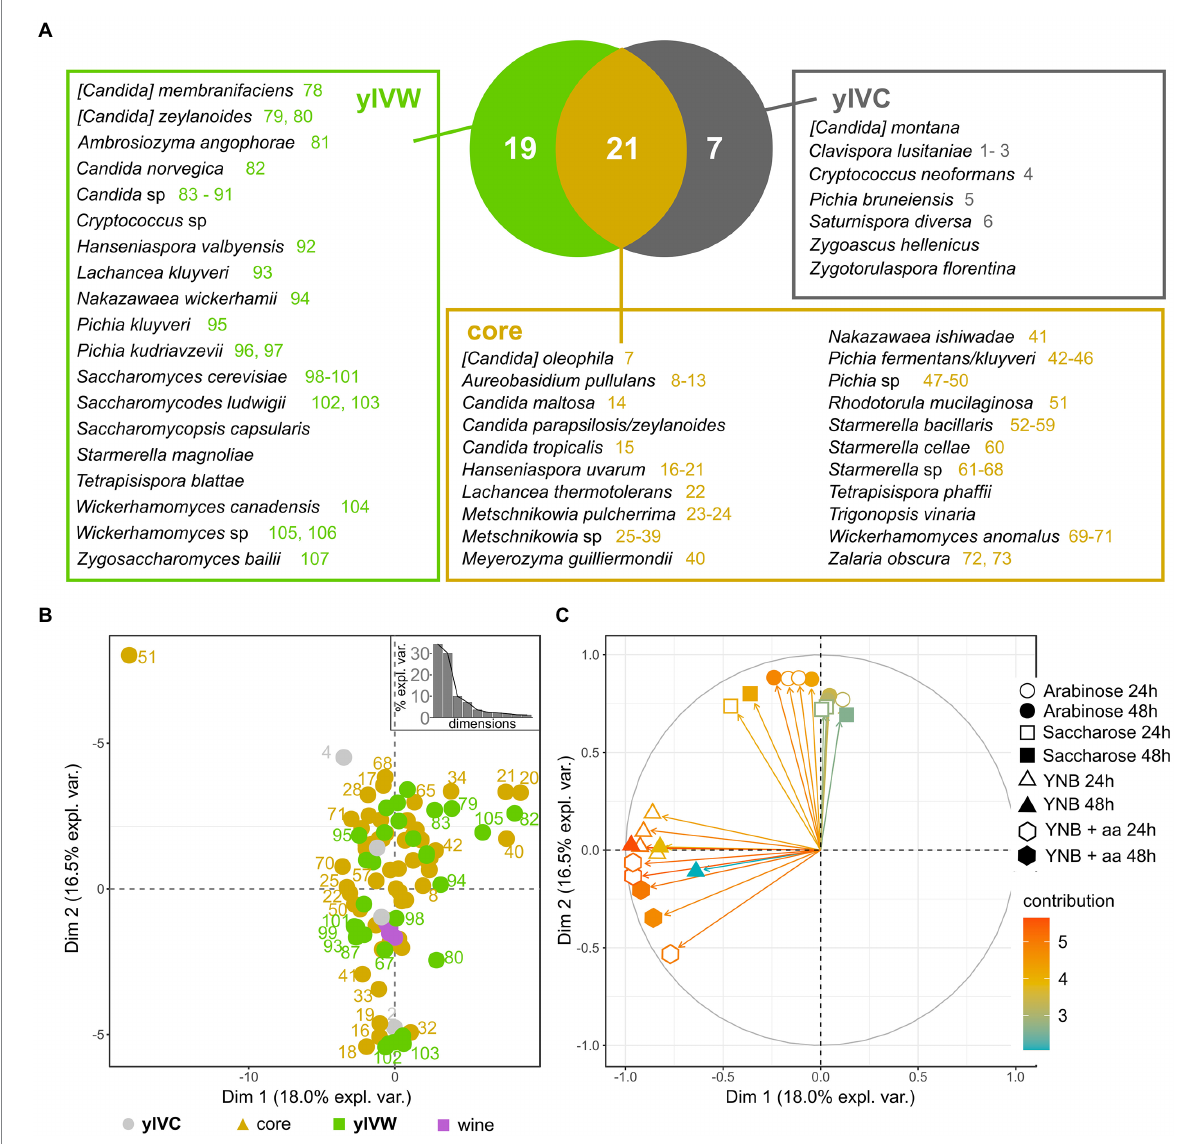
FIGURE 3 Yeast species isolated from the intestines of investigated insects. (A) Venn diagram showing the distribution of yeast species between insects caught from vineyards close to wooded areas (VW) and control vineyards (VC). The yIVW group includes species found only in wood insects, the yIVC group includes species found only in VC insects, and the core group encompasses yeast species found in insects caught in both VC and VW. Colored numbers report the strain IDs indicated in panel B, with the color indicating the group of the yeast species (yIVW, yIVC, or core yeast species). The species without the colored number were not phenotypically characterized. (B) The first two components of the PCA performed on distances calculated on the quantified phenotypes of strains representing the identified species and (C) projection of the variables according to their relevance in the determination of the variance over the first two PCA components. Each variable includes the quantification of the growth of each tested strain in the conditions reported in the legend. Three independent biological replicates were carried out, used in the PCA analysis, and reported in the